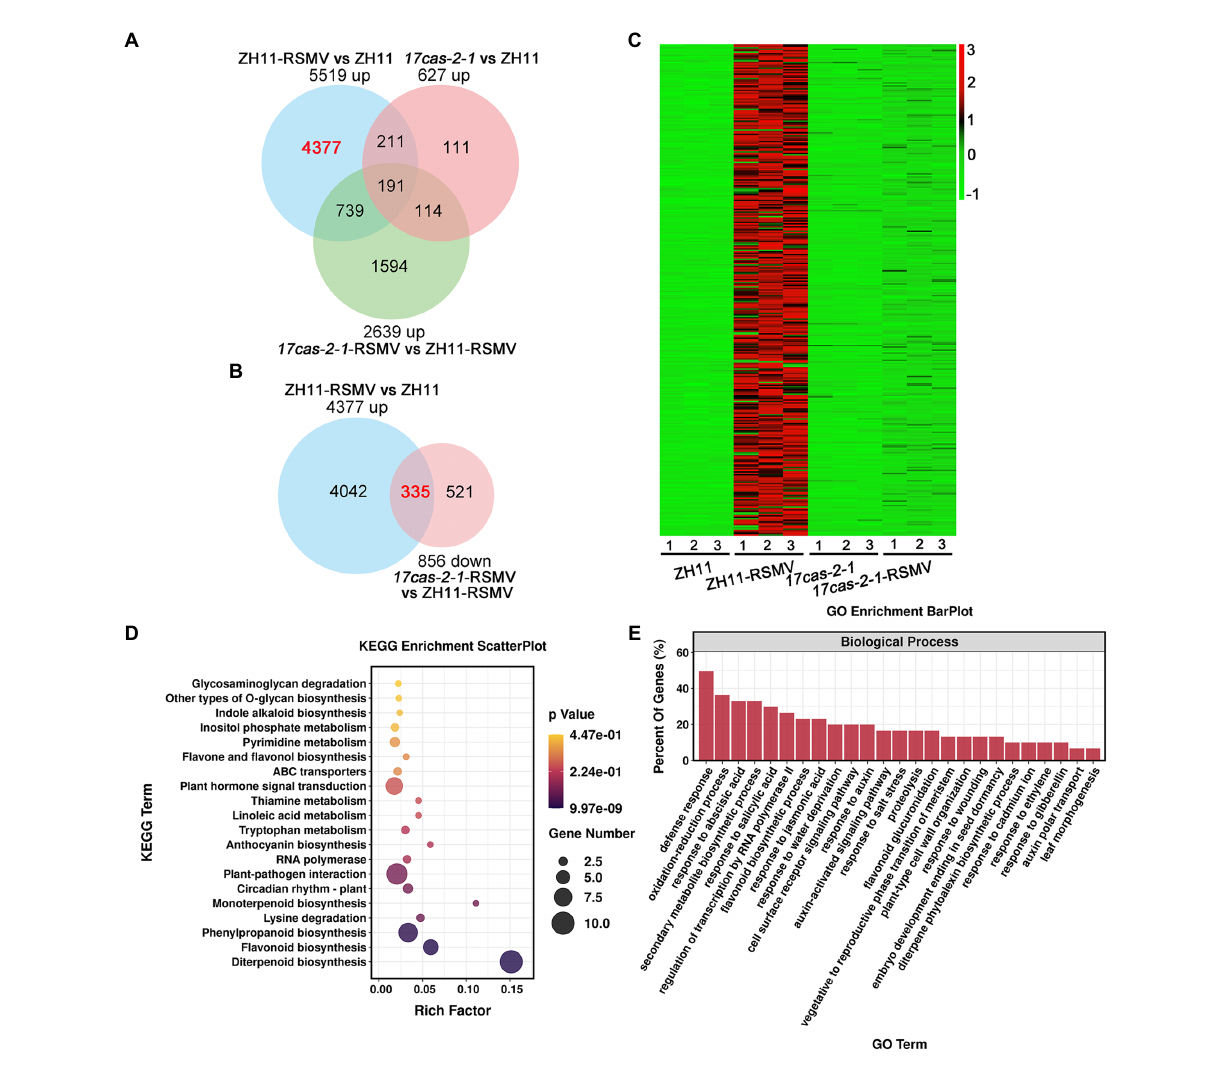
FIGURE 4 Analysis of the differentially expressed genes (DEGs) of overlaps of 4,377 specific up-regulated genes in ZH11-RSMV vs. ZH11 and 856 specific down- regulated genes in 17cas-2-1 -RSMV vs. ZH11-RSMV. (A) Venn diagrams showing overlaps of up-regulated differentially expressed genes in ZH11-RSMV vs. ZH11, 17cas-2-1 -RSMV vs. ZH11-RSMV and 17cas-2-1 vs. ZH11. (B) Venn diagrams showing overlaps of overlaps of 4,377 up-regulated genes in ZH11-RSMV vs. ZH11 and 856 down-regulated genes in 17cas-2-1 -RSMV vs. ZH11-RSMV. (C) Hierarchical clustering of 335 DEGs in (B) based on the log2 fold change in transcript levels in ZH11 and OsARF17 mutant plants under mock or RSMV inoculation. The hierarchical clustering analysis was performed on the FPKM values of all tested genes. (D) KEGG pathway enrichment analyses of 335 DEGs labelled in red in (B) . “Rich factor” shows the ratio between the number of DEGs and the total genes in this pathway. (E) Gene ontology (GO) enrichment analysis of 335 DEGs labelled in red in (B) . The genes were summarized in biological process GO category. All differentially expressed genes were selected using cut-off p -value < 0.05 and fold- change > 2 compared with controls. Data were collected from three biological replicates, each containing a pool of three